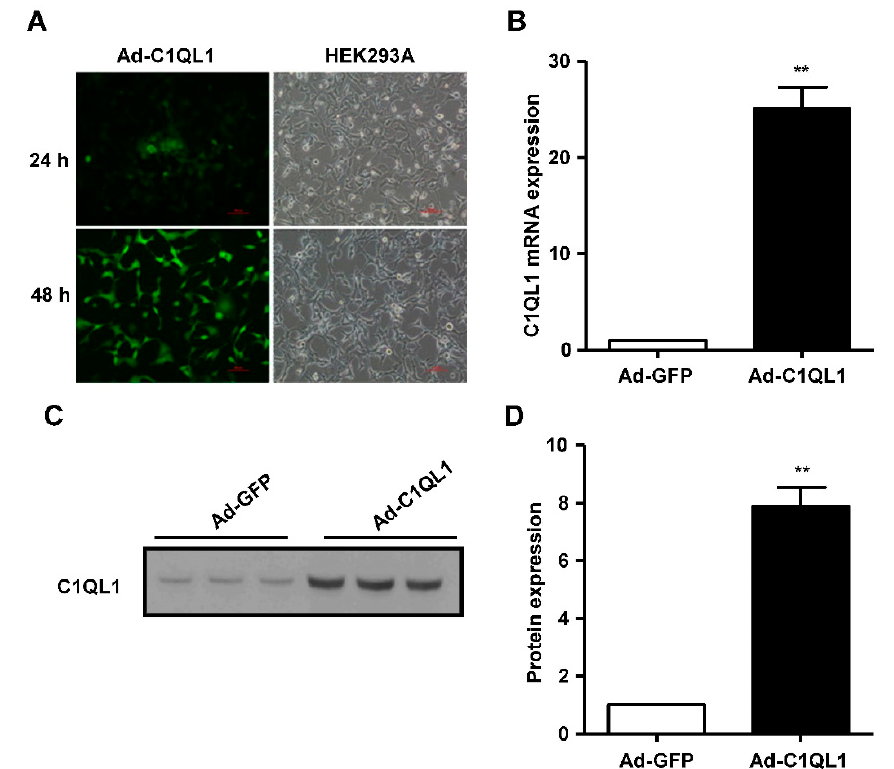
Figure 1. C1QL1 was overexpressed in ApoE KO mice. ( A ) Representative image of adenovirus-infected HEK293A cells. ( B ) RT-qPCR showing the expression of C1QL1 in the Ad-GFP and Ad-C1QL1 cohorts. ( C ) Protein expression of C1QL1 was ascertained by Western blotting (plasma protein was loaded based on the same volume). ( D ) Quantification for C. n = 15 of each cohort. Mean ± SEM. ** p < 0.01, Ad-C1QL1- versus Ad-GFP-injected mice. Ad-GFP, adenovirus green fluorescent protein; C1QL1, C1ql-like 1; RT-qPCR, real-time quantitative polymerase chain reaction (PCR); KO, knockout.